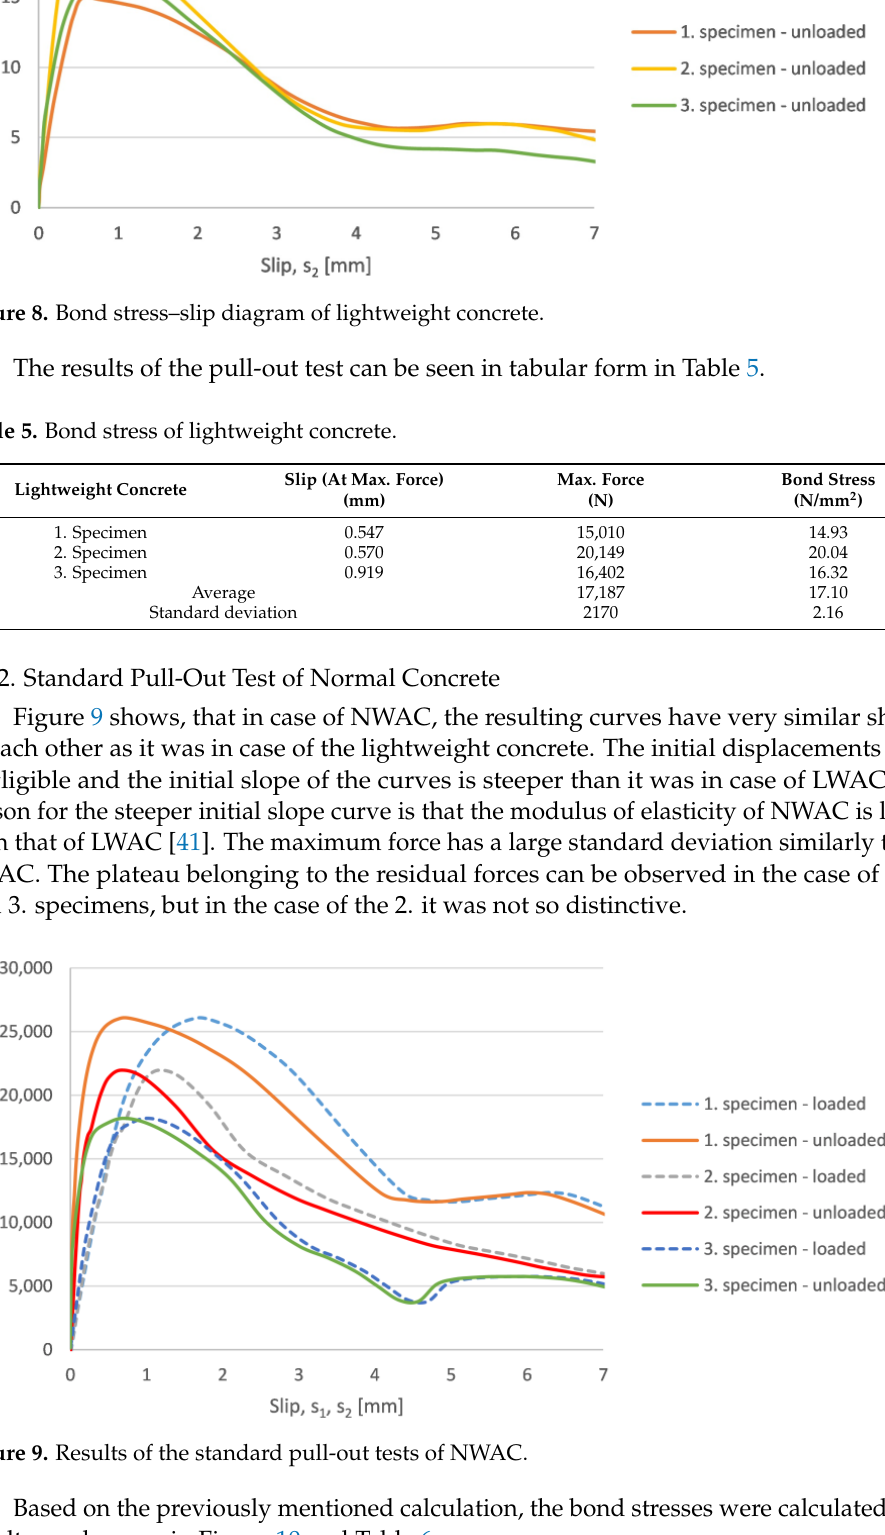
Figure 10. Bond stress – slip diagram of NWAC.